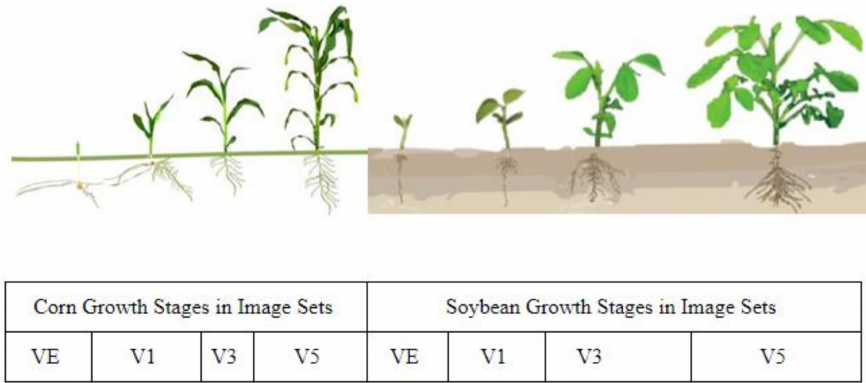
Figure 2. Corn and soybean growth stages (adapted from [52,53]).